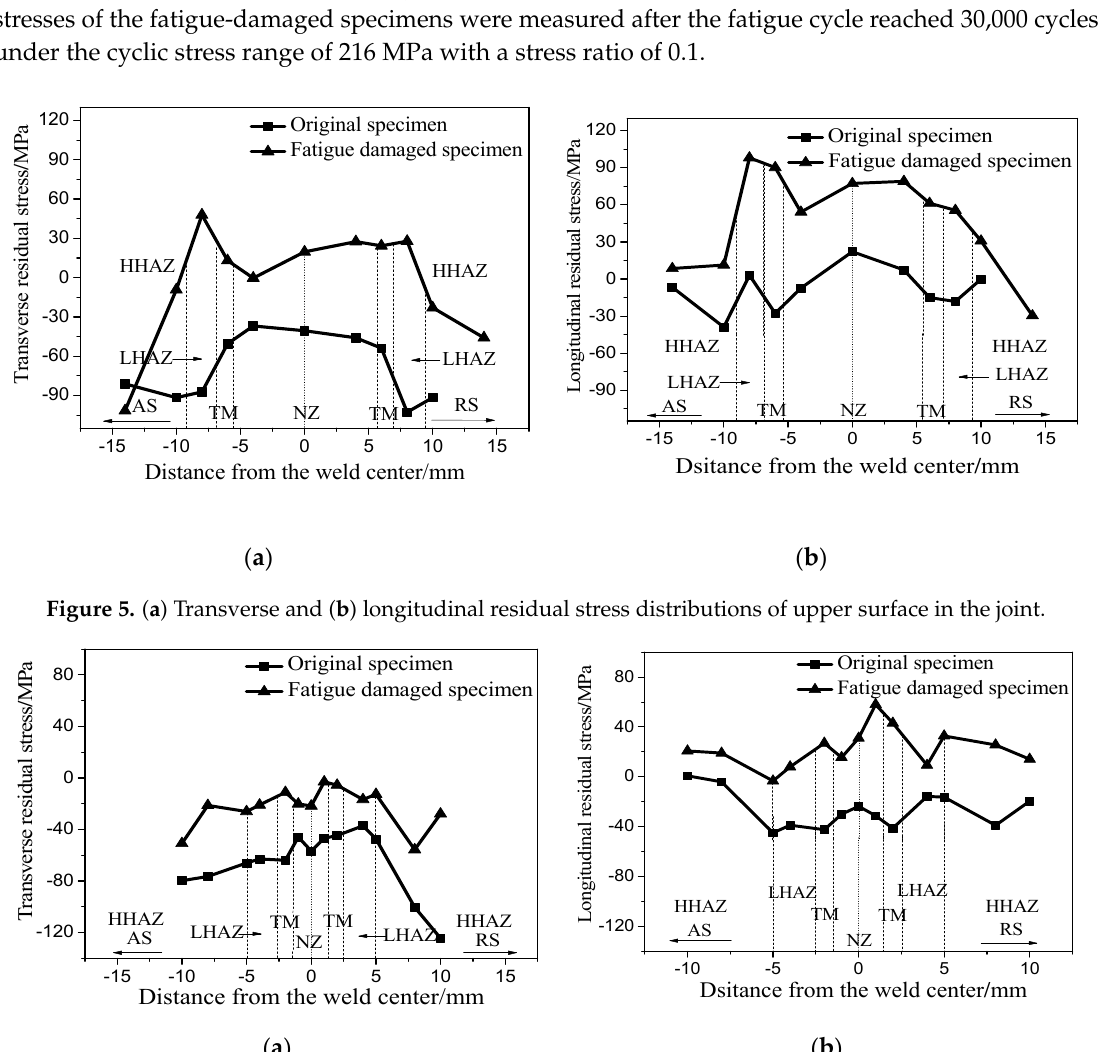
Figure 6. ( a ) Transverse and ( b ) longitudinal residual stress distributions of lower surface in the joint.